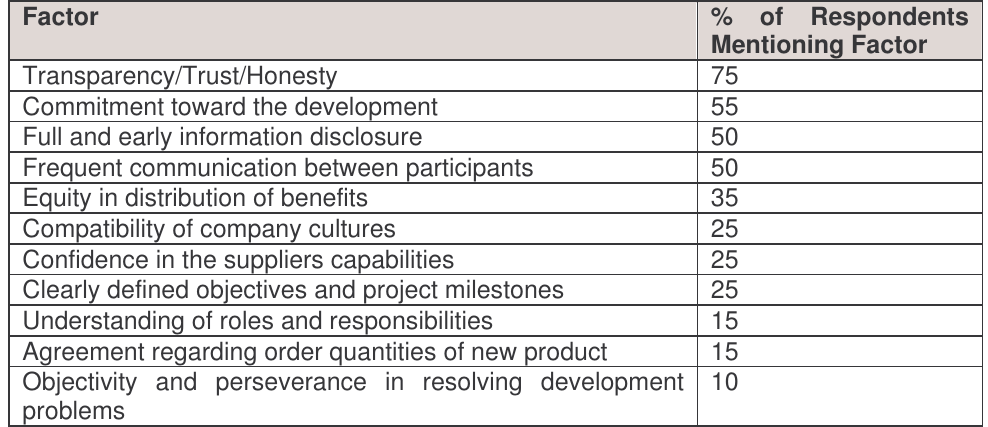
Table 3: Respondent specified factors influencing the outcome of collaborative product